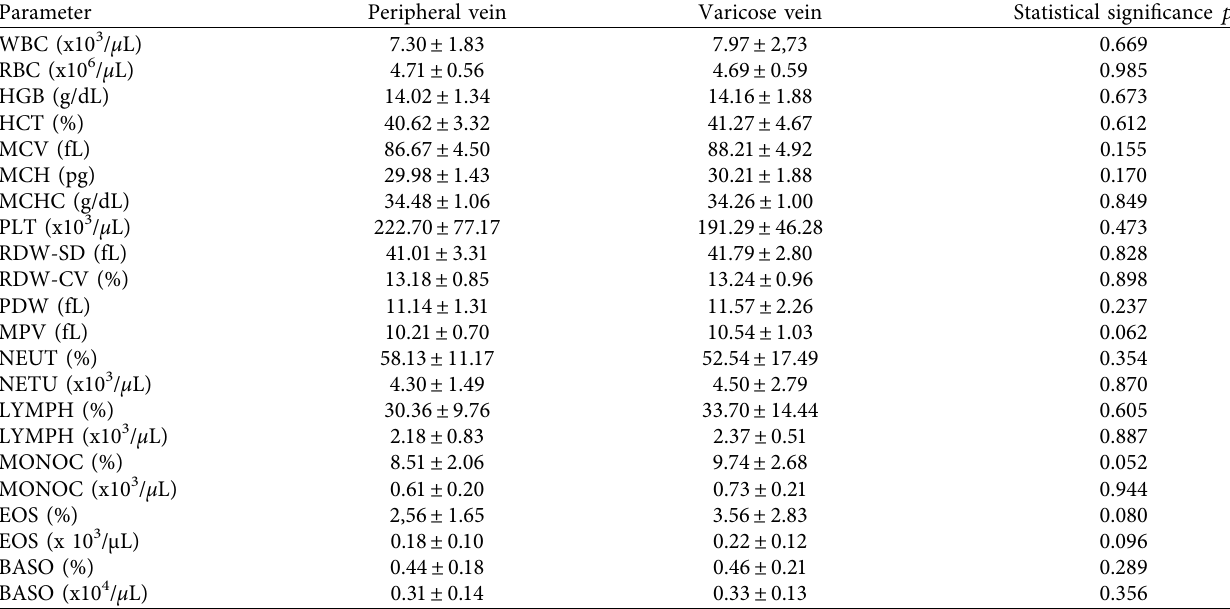
Table 1: Clinical hematology parameters in patients with venous disease.